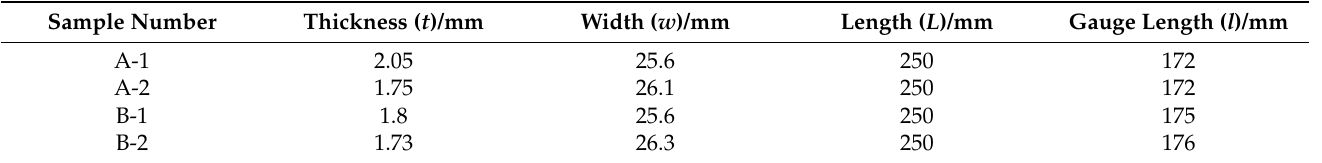
Figure 4. Main geometric parameters of the specimen according to ASTM D3039: ( a ) top view and ( b ) front view. Table 2. Main dimensional parameters of the tensile test specimens where each specimen consisted of seven layers.